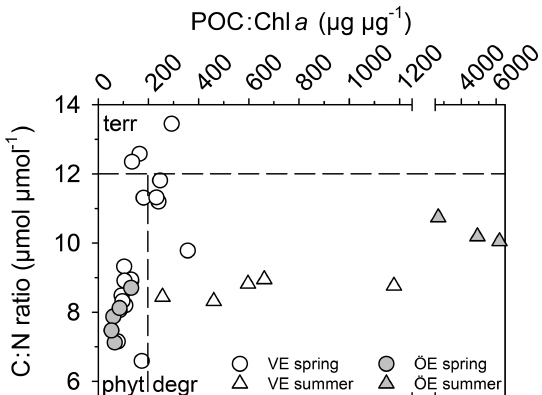
Figure 4. Ratio of particulate C : N ratio plotted against the ratio of POC : Chl a in the BBL of the Vistula (VE) and Öre (ÖE) estuaries in spring and summer. According to Savoye et al. (2003), a C : N ratio of >12 is assigned as terrestrial (terr) particulate organic mat- ter (POM); according to Cifuentes et al. (1988), a POC : Chl a ratio <200 indicates newly produced phytoplankton POM (phyt), and a ratio of >200 degraded phytoplankton POM (degr).